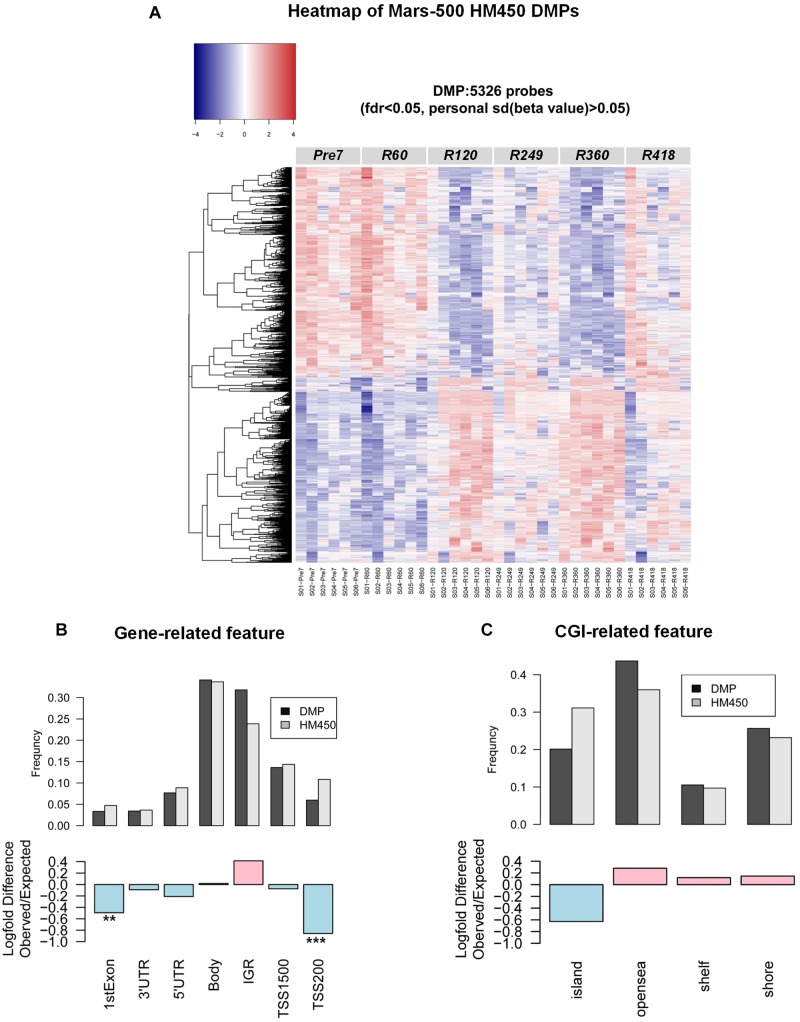
DNA methylation changes in the MARS500 mission. (A) Heatmap of 5326 DMPs in this study. (B) Enrichment of DMPs (differentially methylated-probes during the mission) by genomic location. Log-fold difference of enrichment (observed/expected frequency) in the 5326 DMPs [ANOVA fdr < 0.05, nparLD test fdr < 0.05, and personal sd(β) > 0.02] for specific genomic locations, grouped by association with genes. Pink bar indicates enrichment and light blue bar indicate depletion in the DMPs dataset. P -values. ∗∗P < 1 × 10–20, ∗∗∗P < 1 × 10–50. (C) as in (B), 5326 DMPs for specific genomic locations, grouped by association with CGI. Pink bar indicates enrichment and light blue bar indicate depletion in the DMPs dataset.